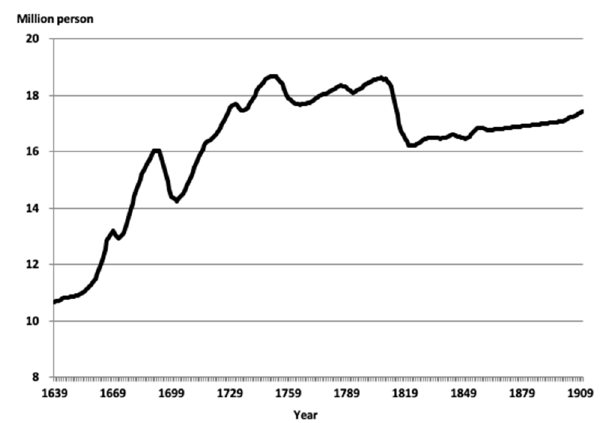
Figure 2. Population changes in the late Joseon Dynasty period from 1639 to 1910 (source: Kwan and Shin, 1977).